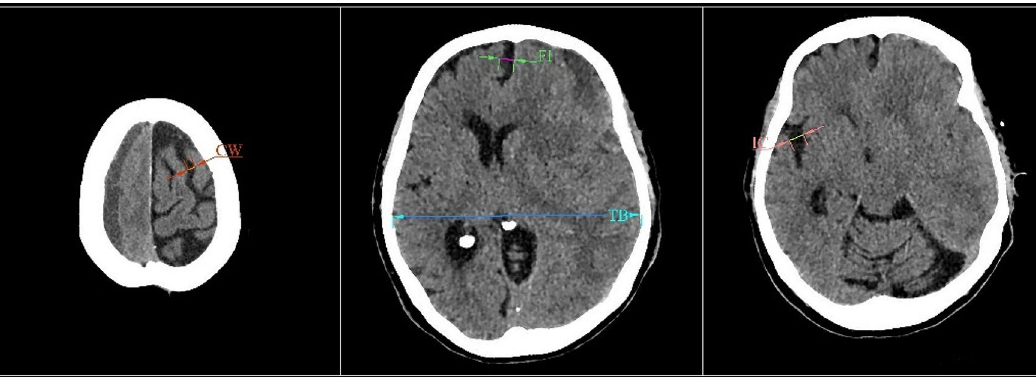
Figure 1. RCA Index is developed on the parameters adopted from Chrzan et al. 1 : the Insular Cisterns width (IC), the longitudinal cerebral fissure width in the anterior part (FI), and the cerebral Sulci greatest Width at the skull vault (SW) in mm in the hemisphere contralateral to the hematoma related to the Temporal Bone greatest internal distance (TB). These parameters are measured on CT scan axial